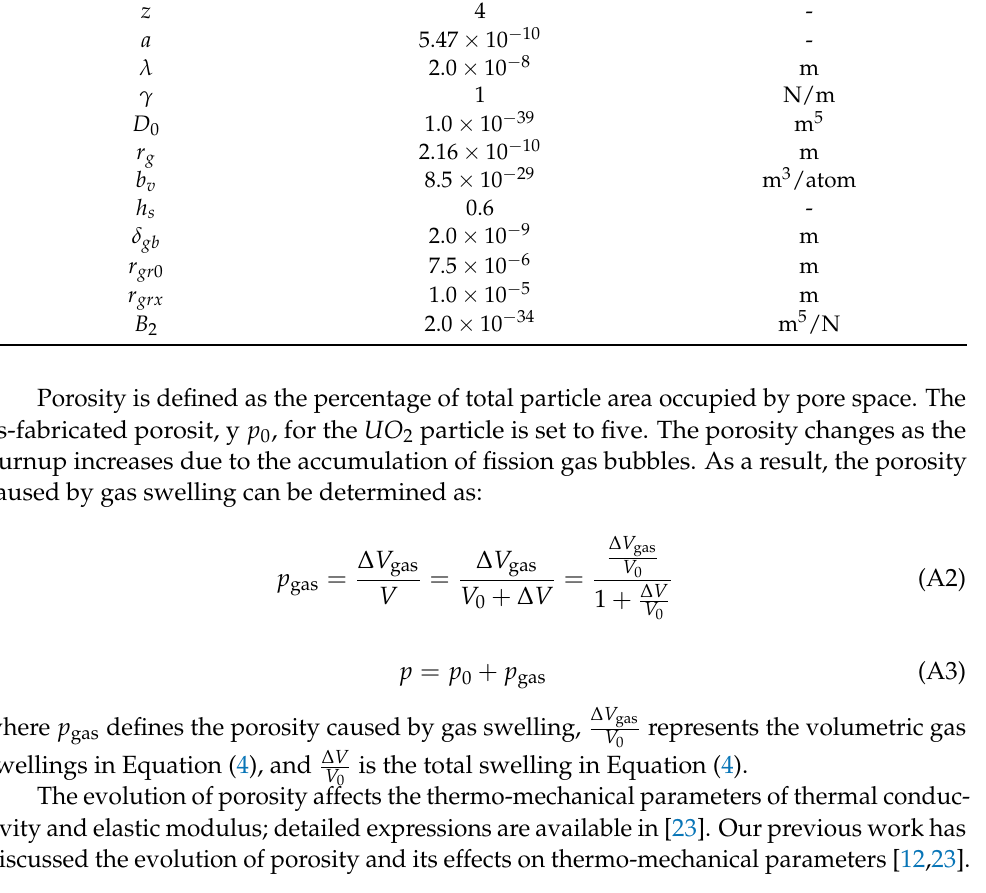
Table A1. The following parameters were used in the gas swelling model for swelling calculations, with recrystallization, resolution effect, and hydrostatic pressure dependency taken into account. Parameter Value Unit Y 0.25 - z 4 - a 5.47 × 10 −